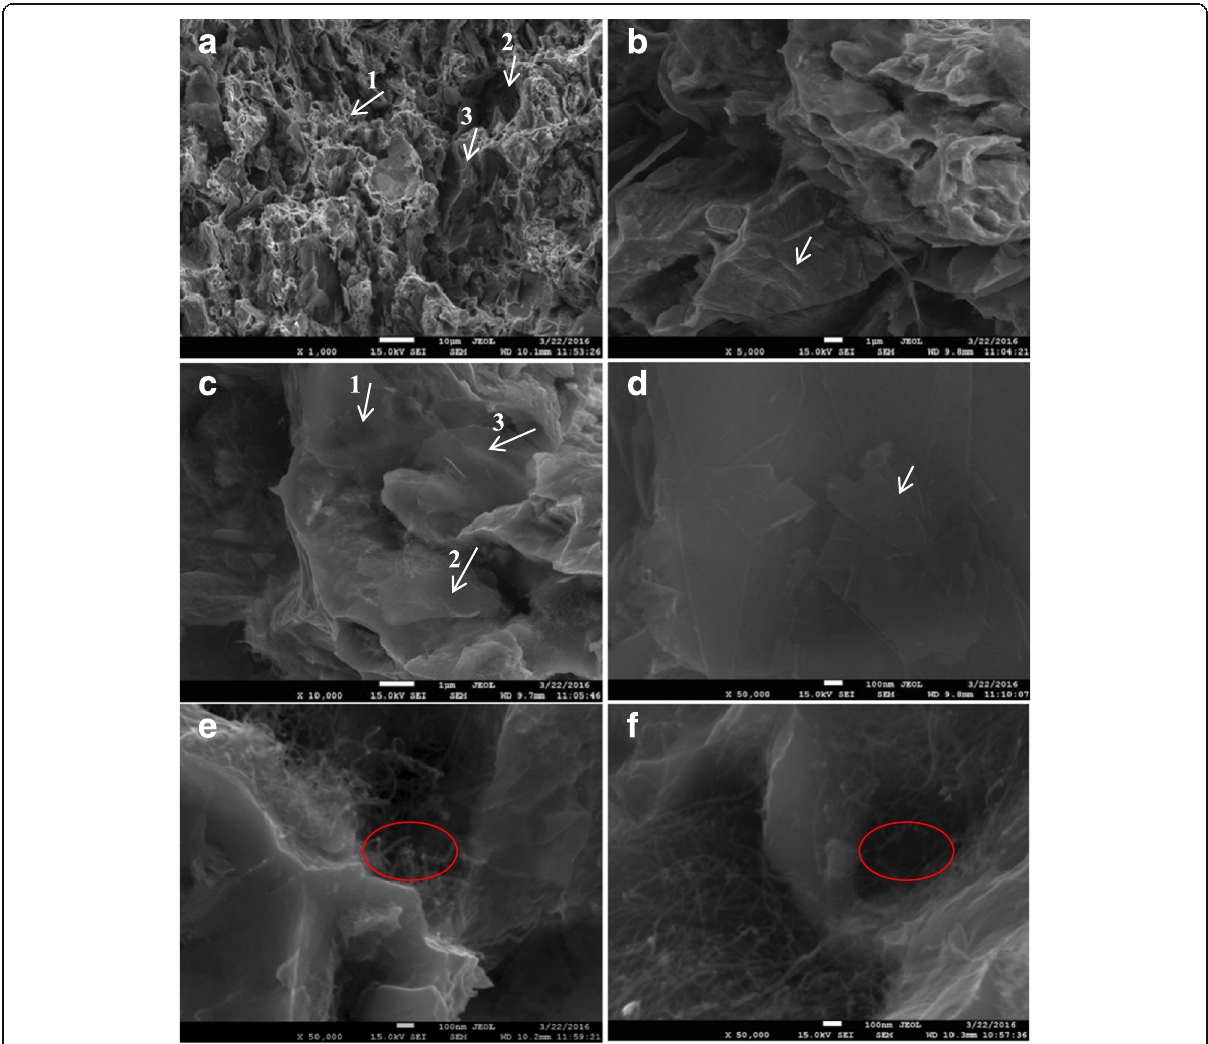
Fig. 10 a − f SEM images of fractures of the sintered nanocomposites with 0.5 wt% graphenes and 0.5 wt%